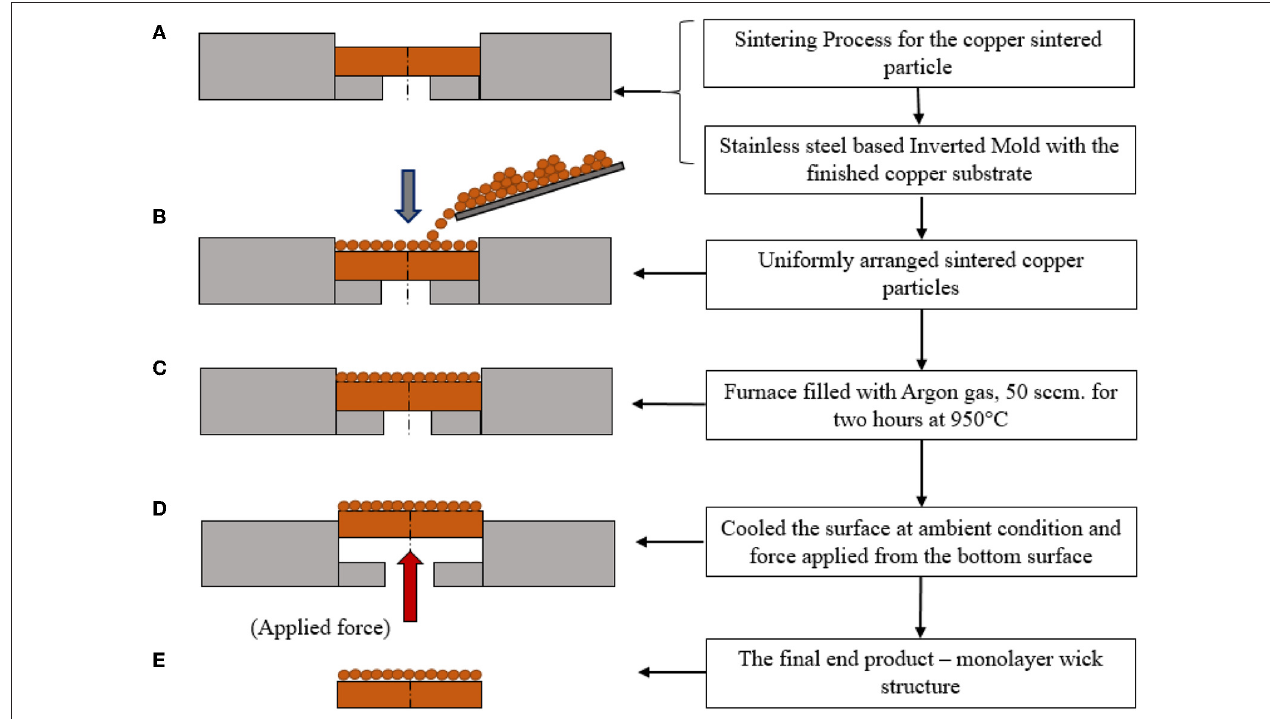
FIGURE 2 | The process flow chart of the sintering process for the wick structure using the copper sintered particles. (A) An assembly of the machined smoothed polished copper surface with a stainless steel mold. (B) Poured and uniformly distributed sintered copper particles in the pocket of mold and the copper substrate. (C) The entire assembly kept in the furnace filled with Argon gas, 50 sccm (cubic centimeter per minute) for 2h at 950 ◦ C. (D) Finally, the surface is allowed to cool at ambient condition. (E) The end product of the single-layer wick structure.